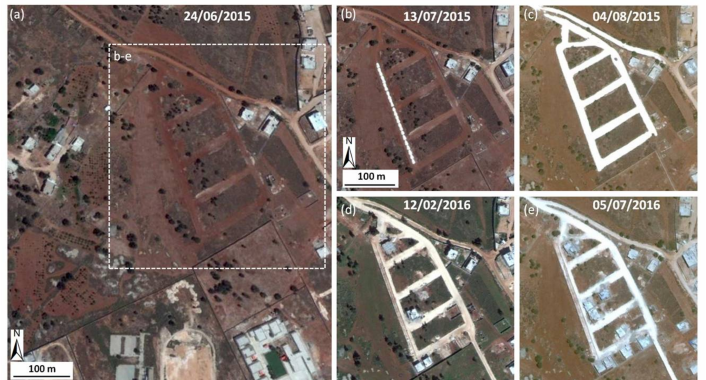
Figure 5. The life cycle of the typical block feature of new urban development in the cultural landscape surrounding the Cyrene WHS (Libya), as reconstructed based on the VHR Google Earth satellite imagery: ( a ) the topsoil is initially excavated (24 June 2015); ( b ) the road pavement is laid down (13 July 2015); ( c ) the road grid enclosing land lots is completed (4 August 2015); ( d , e ) the land lots are being populated by houses, dwellings, and farming activities (12 February 2016 and 5 July 2016). Google Earth imagery © 2018 DigitalGlobe.